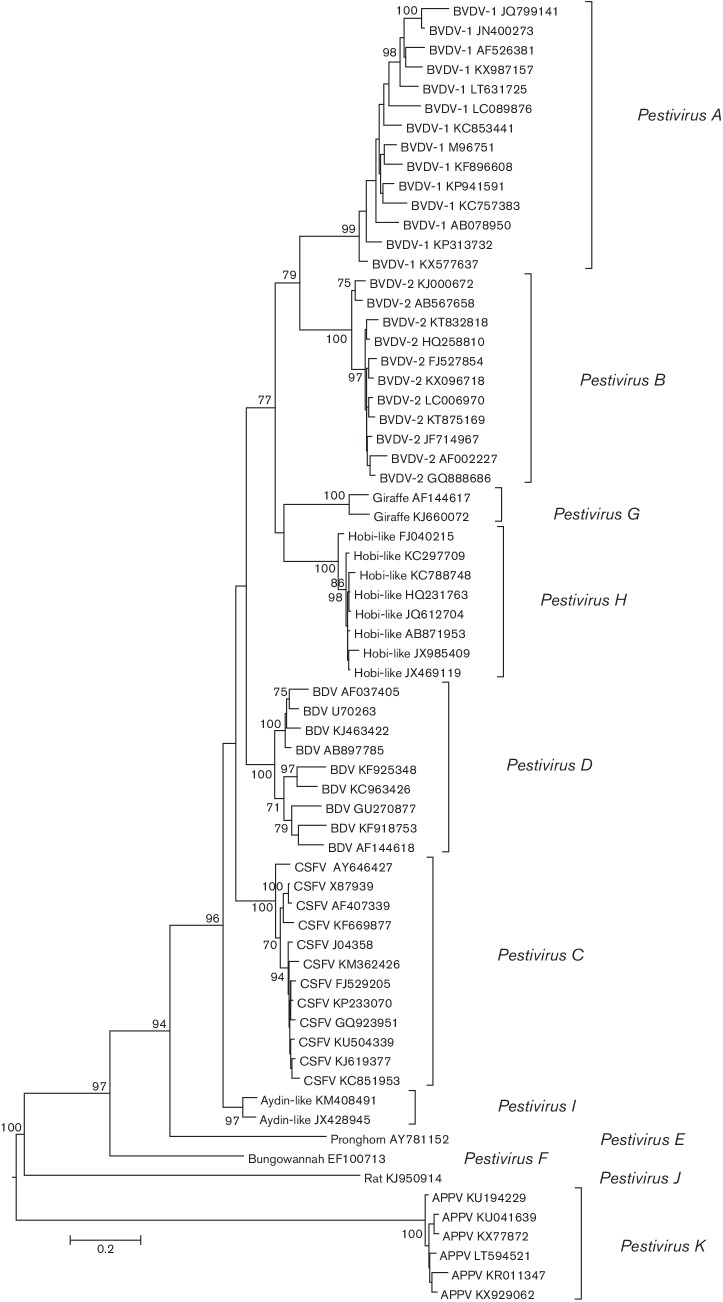
Phylogenetic analysis of pestivirus polyprotein fragments. Phylogenetic trees
were constructed using mega 6 [36] and based upon distances between amino acid sequences for
amino acid positions 3312–3899 by maximum likelihood using a JTT+G
model. Up to 15 sequences were used for each species, choosing the most
divergent sequences and eliminating sequences <1 % divergent, and
comprised: BVDV1 (M96751, JQ799141, KP313732, KP941591, JN400273, KF896608,
KC757383, KC853441, AB078950, AF526381, LC089876, KX577637, KX987157,
LT631725), BVDV2 (AF002227, LC006970, KT875169, KT832818, KJ000672,
HQ258810, JF714967, AB567658, FJ527854, GQ888686, KX096718), CSFV (X87939,
J04358, FJ529205, AY646427, KF669877, KP233070, KM362426, KJ619377,
KC851953, GQ923951, AF407339, KU504339), BDV (AF037405, AB897785, KJ463422,
KF925348, KF918753, KC963426, GU270877, U70263, AF144618), Hobi-like
(FJ040215, KC788748, KC297709, JX985409, JX469119, JQ612704, HQ231763,
AB871953), giraffe (AF144617, KJ660072), Aydin-like (KM408491, JX428945),
pronghorn (AY781152), rat (KJ950914), Bungowannah (EF100713), APPV
(KU041639, KR011347, KU194229, LT594521, KX77872, KX929062). Branches
supported by >70 % of bootstrap replicates are indicated.